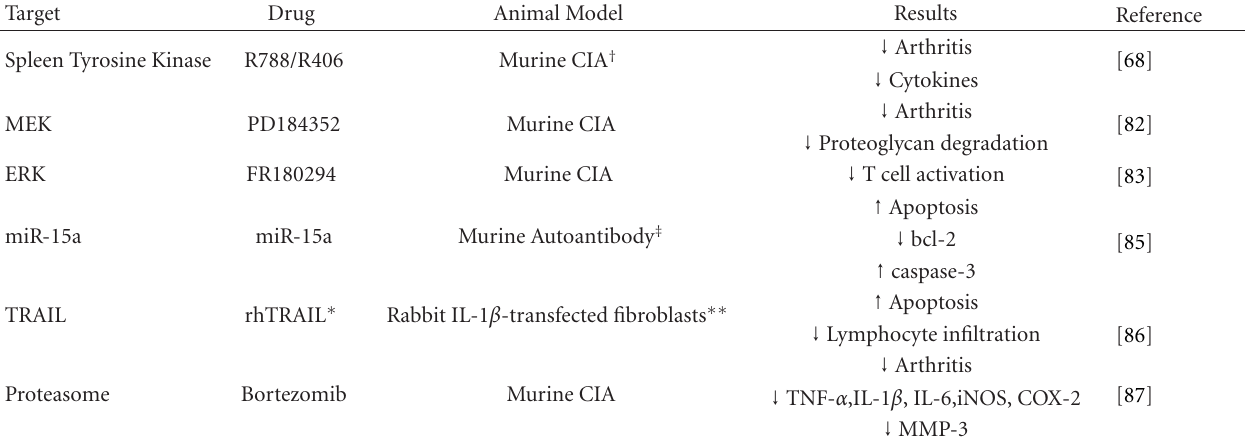
Table 1: Some novel experimental therapies alter the severity of arthritis in animal